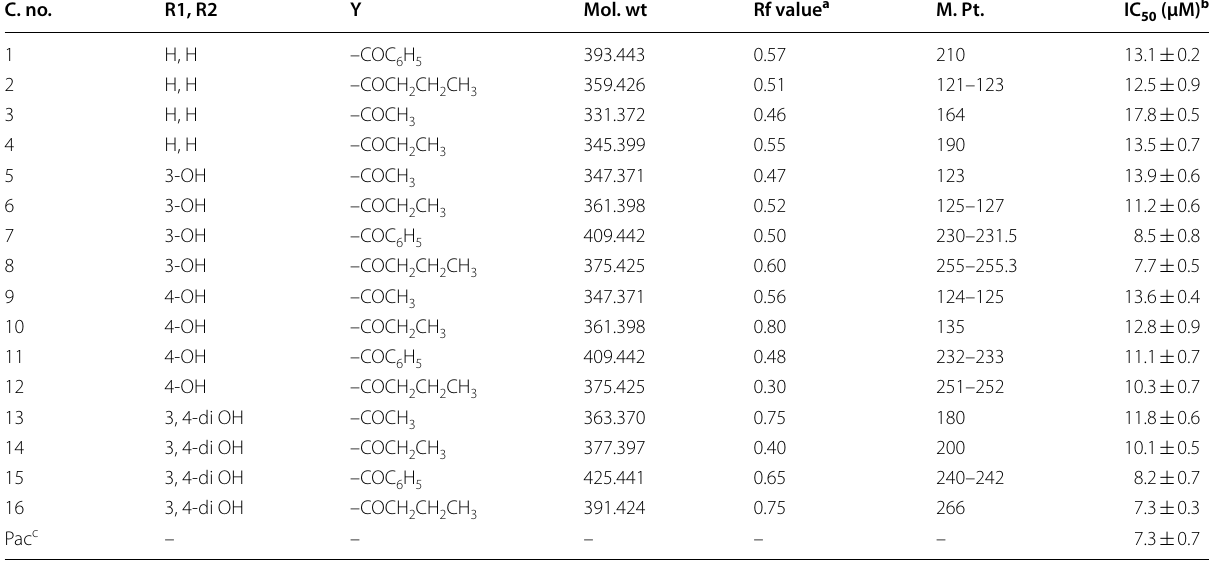
uation on A549 cell lines